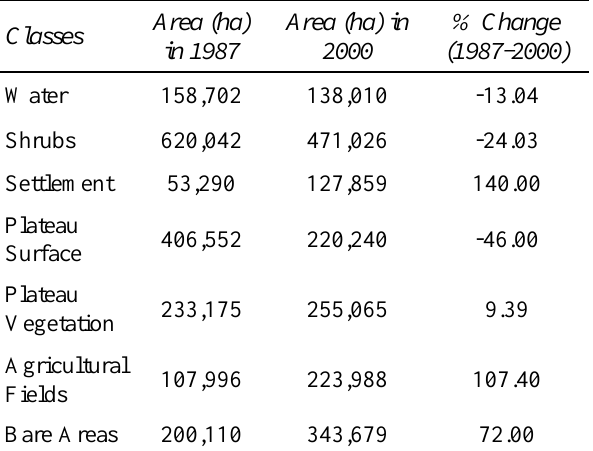
Table 2.5: Projected water demand - Water demand forecasts for two West African Countries